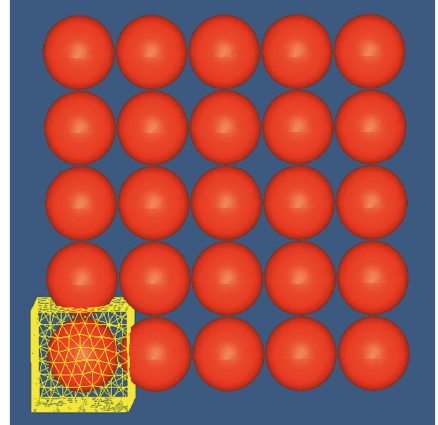
Figure 10: The model of a 5 × 5 sphere array.